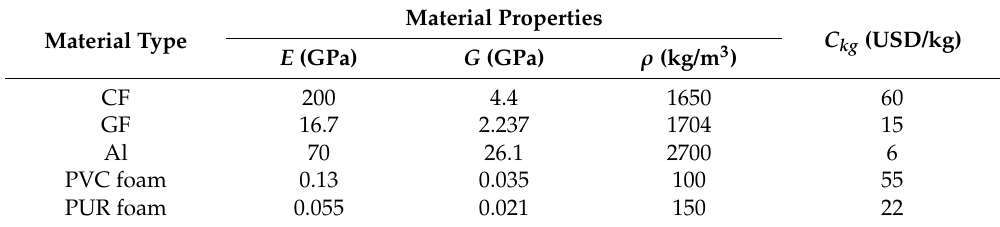
Table 3. Materials properties and the costs used within the optimization studies.